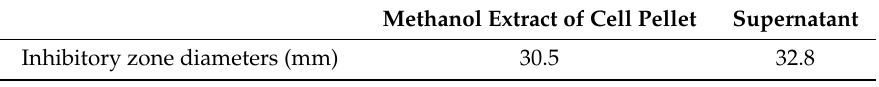
Table 1. Bioactivities of the supernatant and cell pellet of NEAU-HV9 against R. solanacearum . Methanol Extract of Cell Pellet Supernatant Data shown are the mean of two replications.